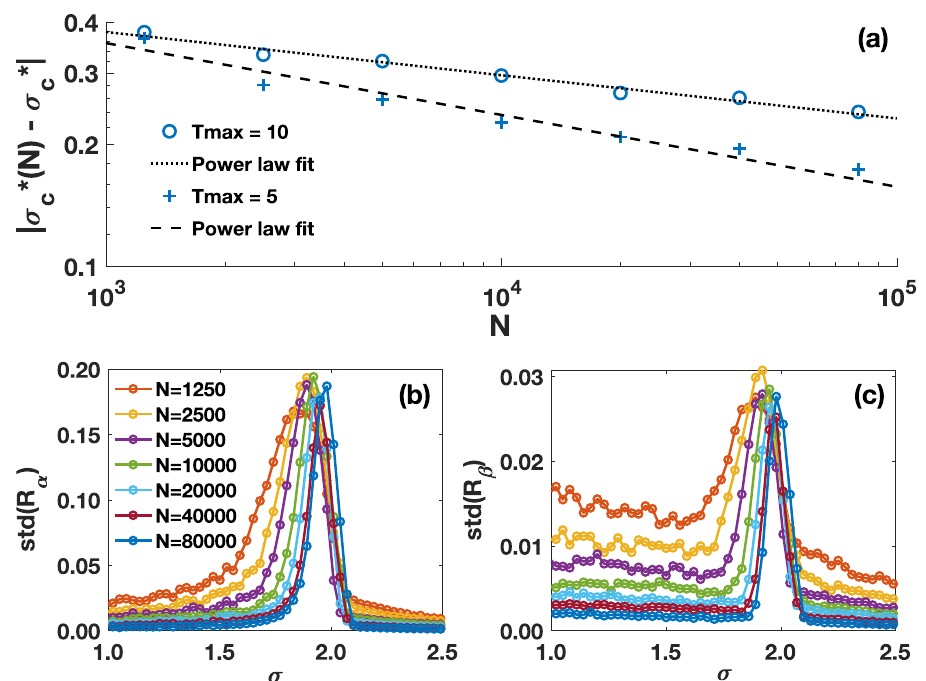
Fig. 4 The fi nite size effects on σ ? c . a Shows the absolute value of the difference between the synchronization threshold σ ? c ð N Þ in a network of N nodes and the theoretical prediction σ ? c of the synchronization threshold in an in fi nite network. The value of σ ? c ð N Þ shown are averaged over 100 independent realizations of the forward transition. We fi nd that these fi nite size effects depend on the equilibration time T max (here shown for T max ¼ 5 and 10). Indeed, for larger integration times, the probability that fi nite-size fl uctuations about the incoherent size bring the system to the basin of attraction of the rhythmic phase increases. Thus, the observed transition point depends on N (larger N implies smaller fl uctuations), and T max (larger T max implies larger probability of transition before reaching σ (cid:5) c ). This process has negligible effect on the rest of the phase diagram. The fi nite size effects are fi tted by a power-law scaling function j σ ? c ð N Þ (cid:3) σ ? c j ¼ cN (cid:3) ξ with c = 1.208, ξ = 0.177 and c = 0.7906, ξ = 0.1065 respectively for T max ¼ 5 (dashed line) and T max ¼ 10 (dotted line). The standard deviation (over the 100 iterations, T max ¼ 5) of the order parameters R α and R β are shown in the forward transition in panels ( b ) and ( c ) respectively. This is highest closest to the transition point, and tends to the theoretical estimate as N increases.